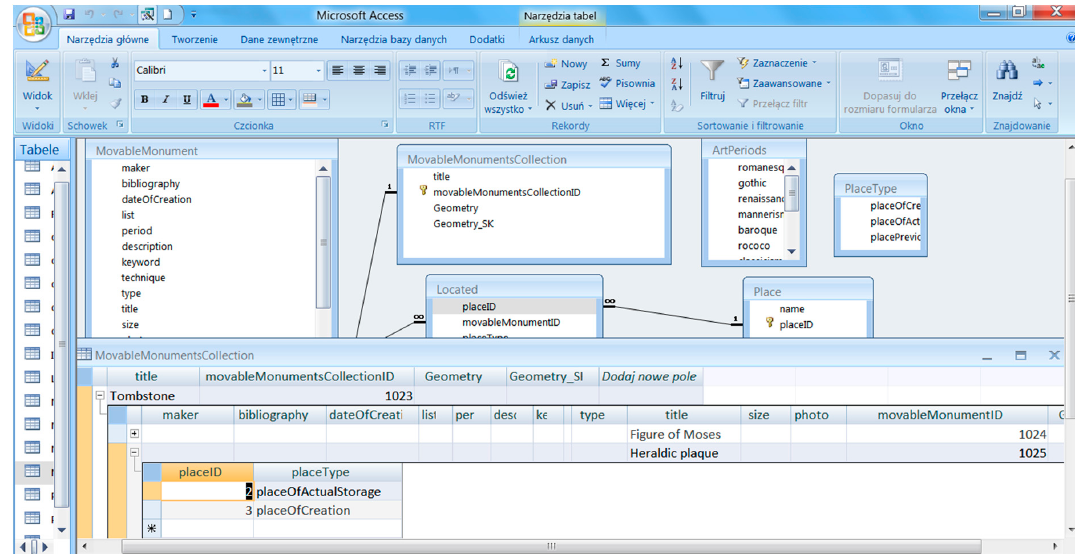
Figure 11. Database structure implementation in Microsoft Access (source: own work).